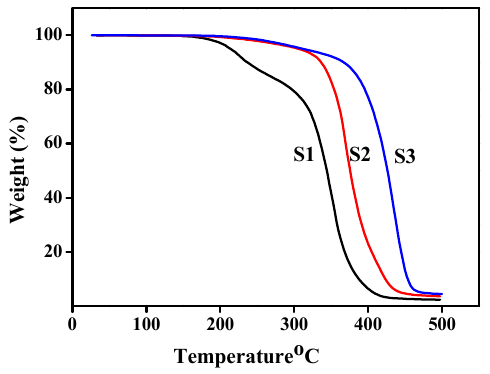
Figure 7. TGA analyses of S1, S2 and S3.